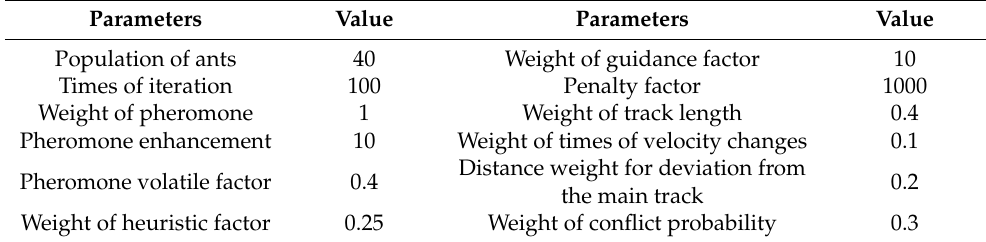
Table 3. Algorithm and tuning parameters.